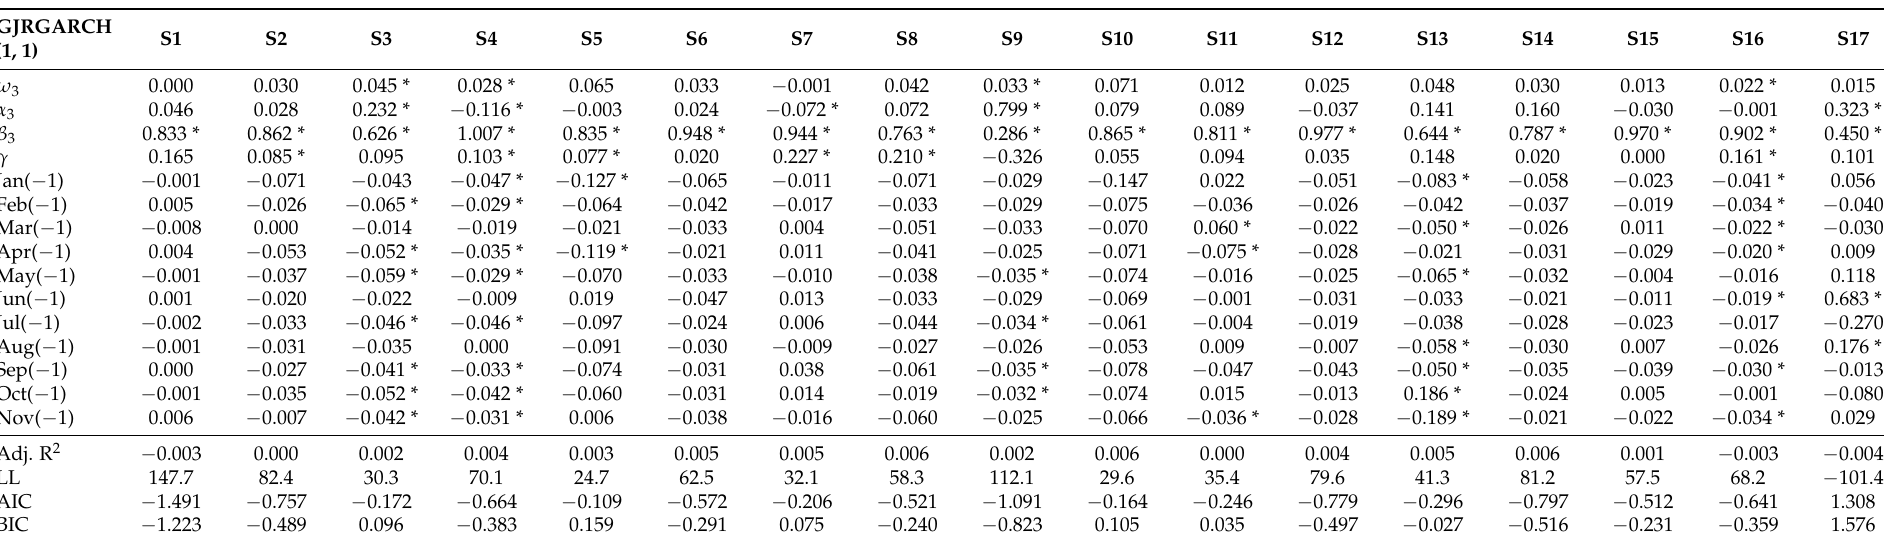
Table 7. GJRGARCH (1,1) conditional variance